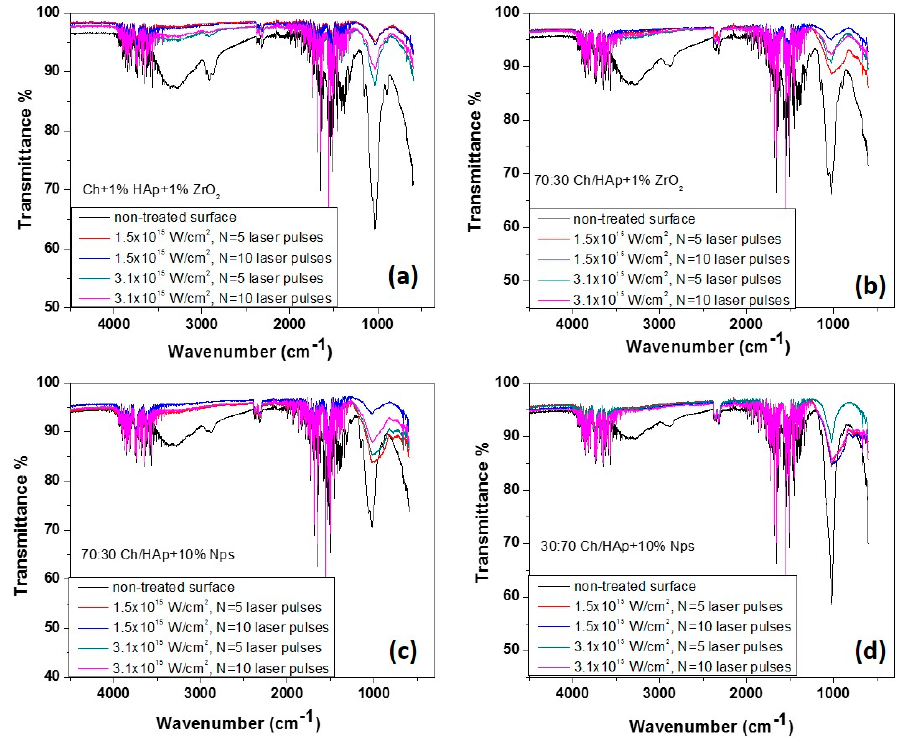
Figure 10. FTIR spectroscopy of chitosan/ceramic blends after laser irradiation at N = 5 and 10, and I = 1.5 × 10 15 W/cm 2 , I = 3.1 × 10 15 W/cm 2 . ( a ) Ch + 1% HAp + 1% ZrO 2 ; ( b ) 70:30 Ch/HAp + 1% ZrO 2 ; ( c ) 70:30 Ch/HAp + 10% Nps; ( d ) 30:70 Ch/HAp + 10% Nps.